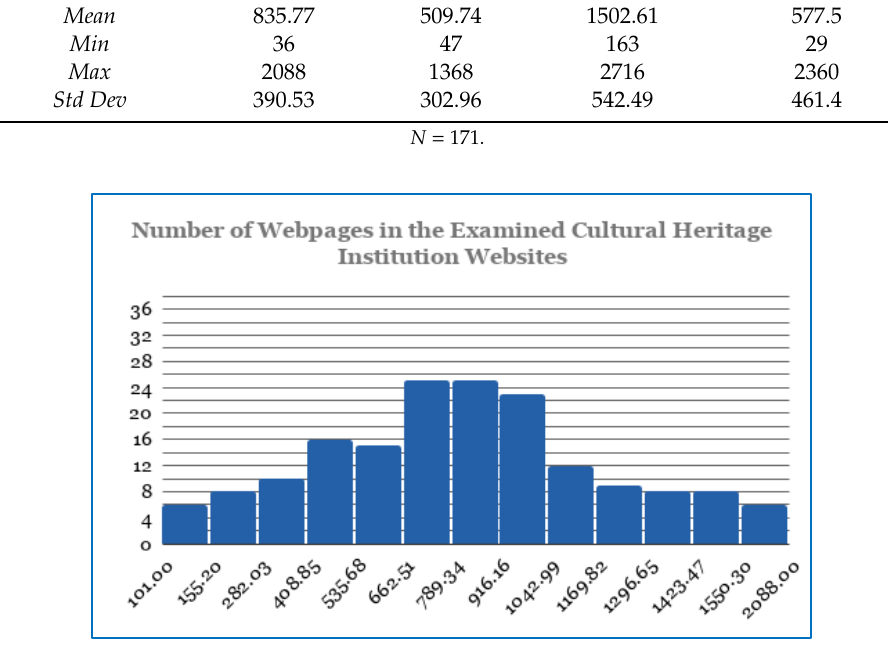
Figure 1. Histogram of the number of unique webpages that the examined CHI websites contain. The horizontal axis indicates the numerical amount of unique webpages that the examined websites contain. The vertical axis demonstrates how many websites contain from 101 up to 2088 unique webpages. For instance, there are 16 websites of the total 171 that ranged from 408 up to 535 unique webpages and 25 of the total 171 websites that ranged from 662 up to 789 unique webpages.